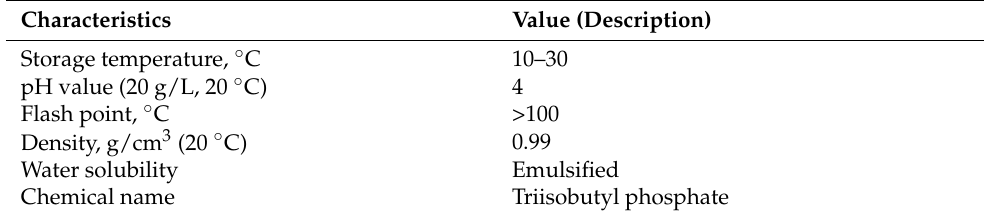
Table 3. Technical parameters of defoaming agent.